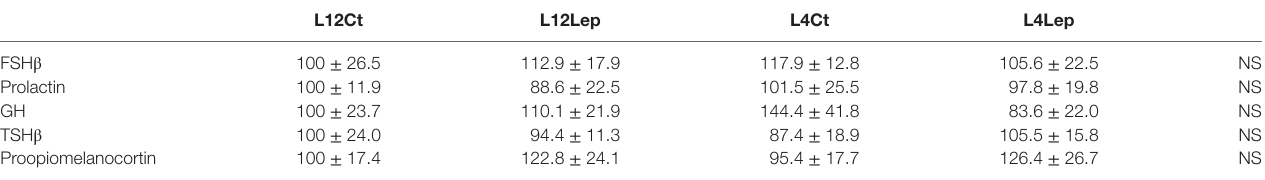
TaBle 1 | Relative levels of mRNA of selected genes in the pituitary of male peripubertal rats from litters of 12 (L12) or litters of 4 (L4) pups that were treated with vehicle (control, CT) or leptin (Lep) and sacrificed 2 h